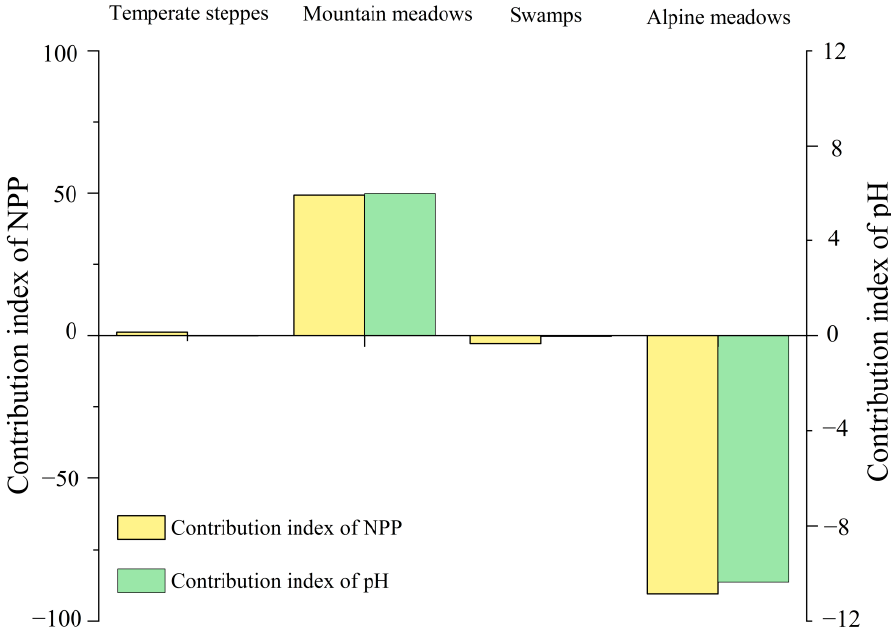
Figure 9. Contribution index of grassland ecosystems to pH and NPP in summer from 2000–2021.